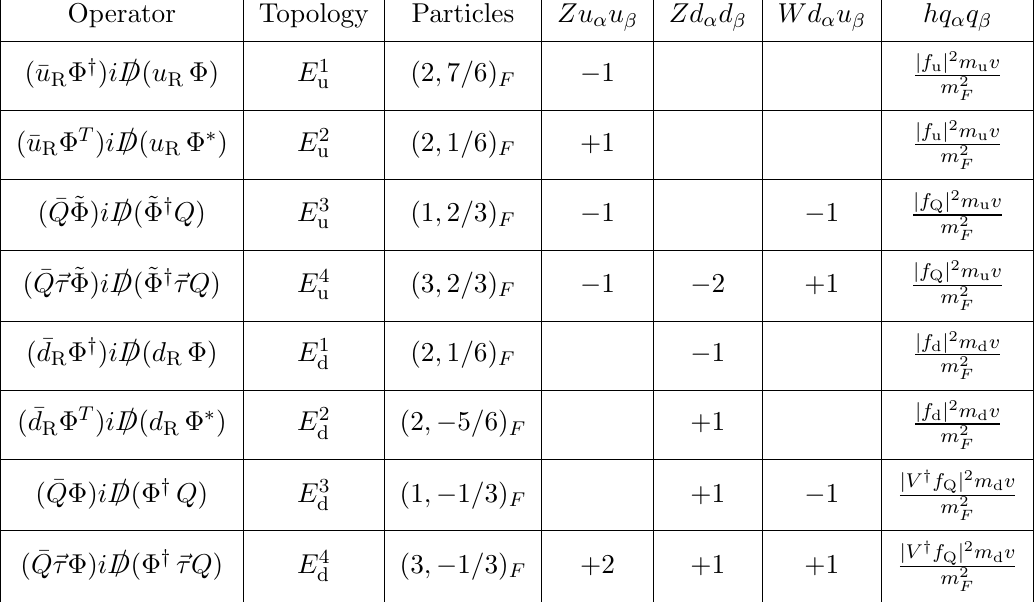
Table 3 . Tree-level topologies of the Derivative operators . The Higgs interactions in the last column correspond to the e(cid:11)ective Yukawa couplings y q , provided in eq. (2.1), with q = u ( q = d ) for the (cid:12)rst (last) four rows. Z couplings are in units of y q v=m q (cid:2) e= (2 c W s W ), while W ones